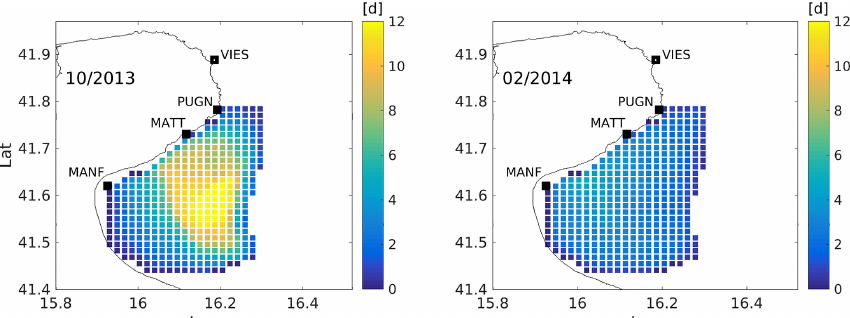
Figure 15. Maps of the Gulf of Manfredonia showing monthly bootstrap estimates of average residence times (in days) of virtual particles advected in the HFR velocity field and released within the gulf for the months of October 2013 (left panel) and February 2014 (right panel). Black squares represent the locations of the four HFR antennas along the Gulf of Manfredonia. Adapted from Sciascia et al.